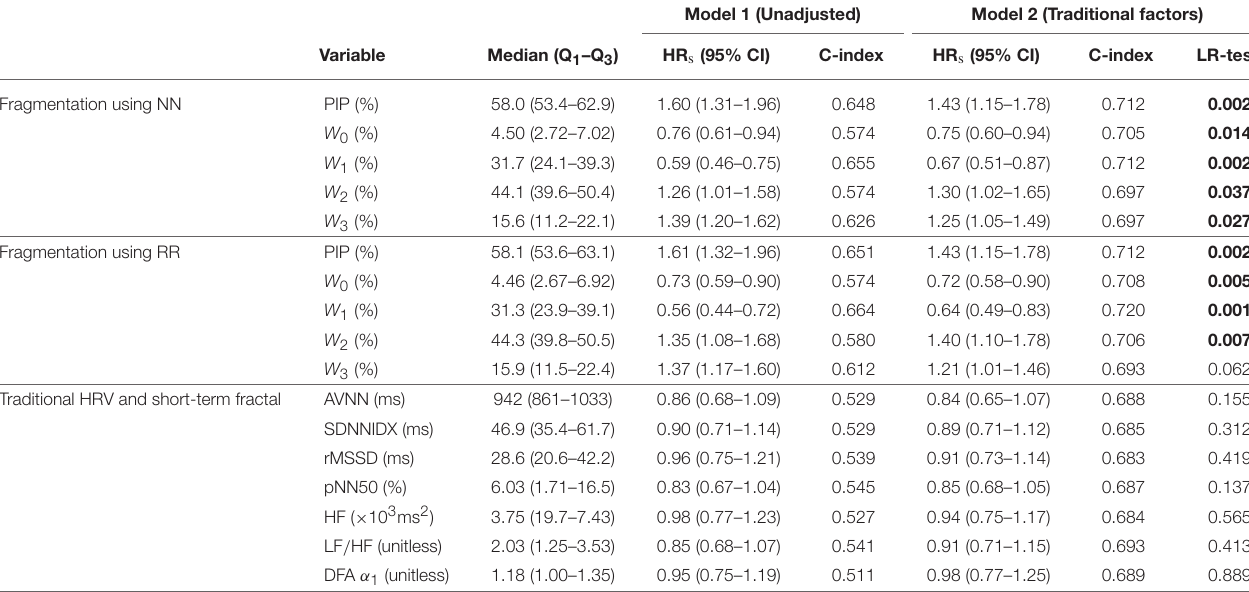
TABLE 2 | Association of fragmentation, traditional HRV and short-term fractal indices with incident CVEs in unadjusted and adjusted models for standard risk factors. Model 1 (Unadjusted) Model 2 (Traditional